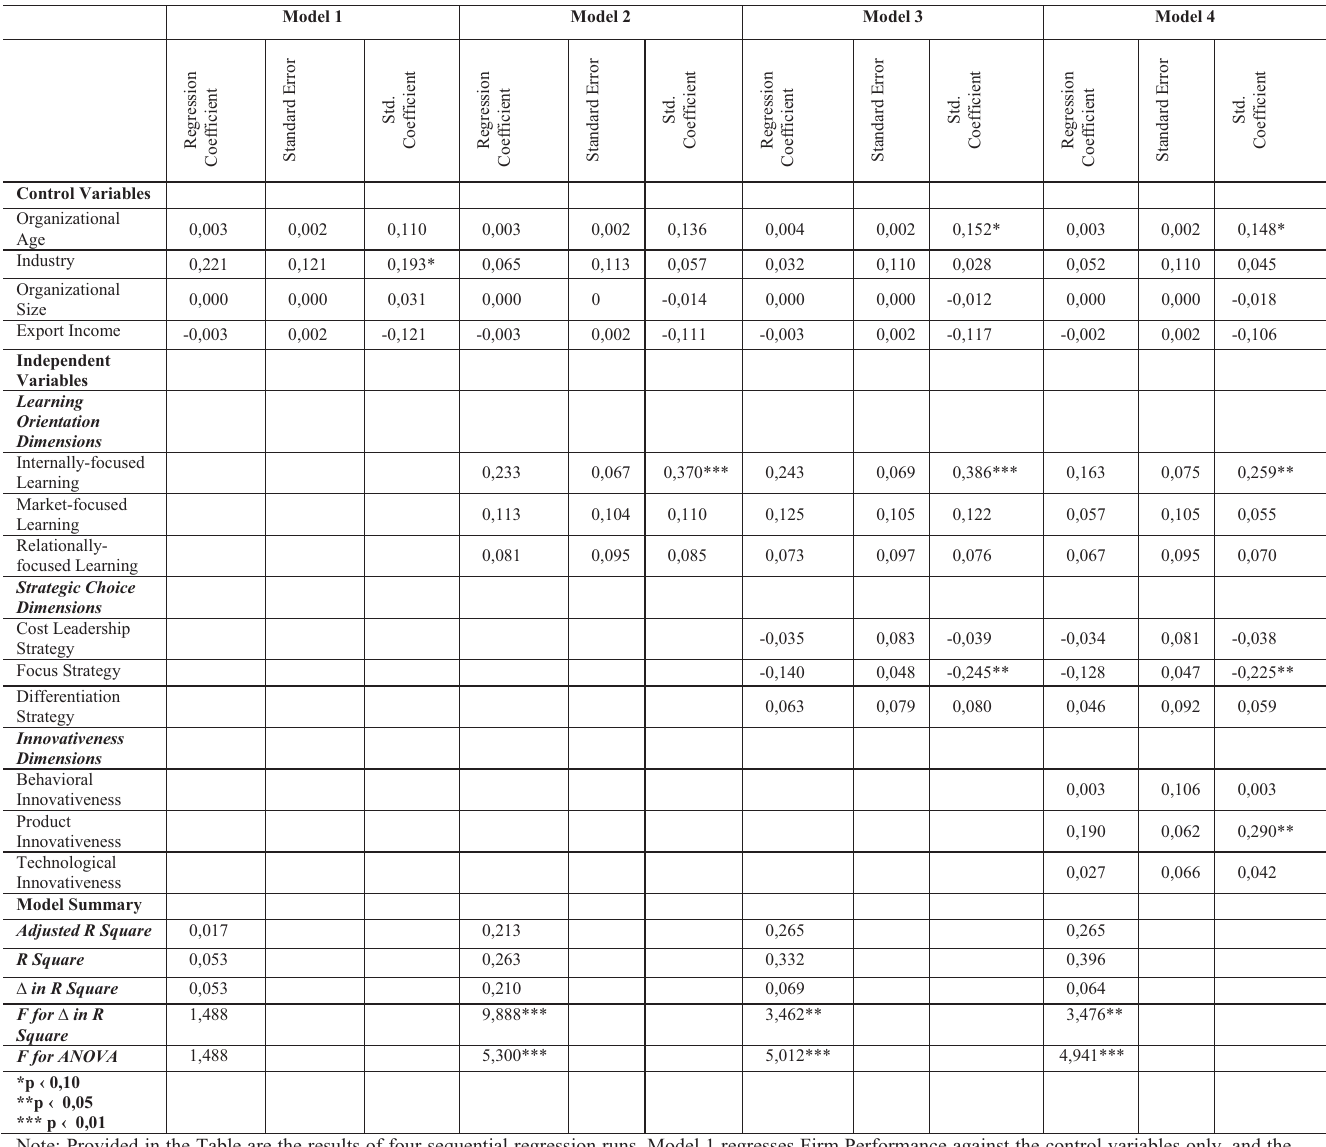
Table 6: Regression results for firm